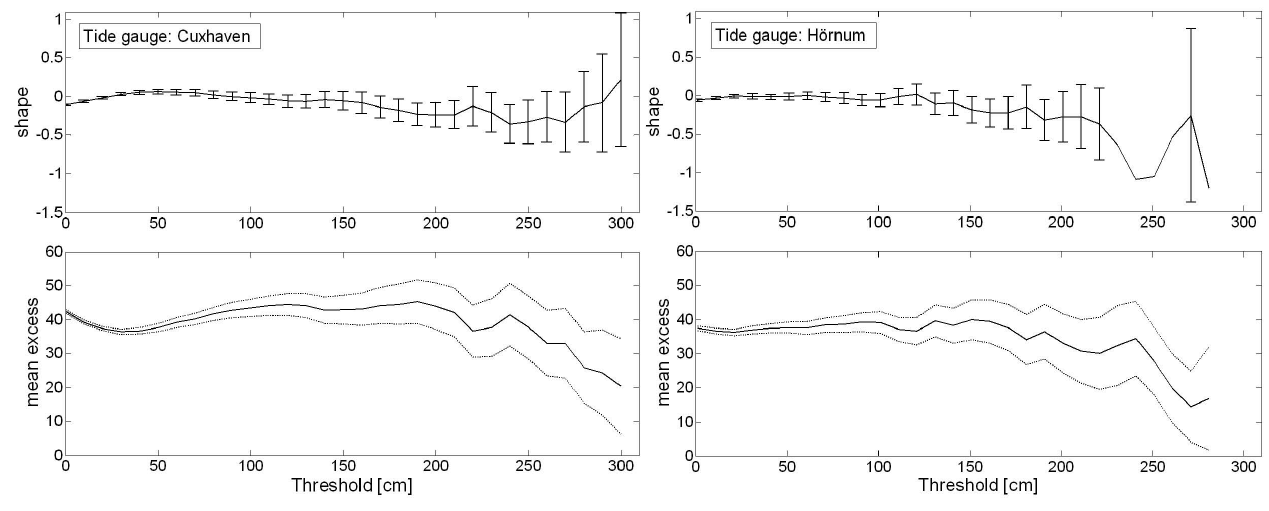
Fig. 3. Results of the Stability Method (top) and Mean Residual Life plots (bottom) with 95%-confidence bounds to identify appropriate thresholds based on the tidal high water time series for the tide gauges of Cuxhaven (left) and H¨ornum